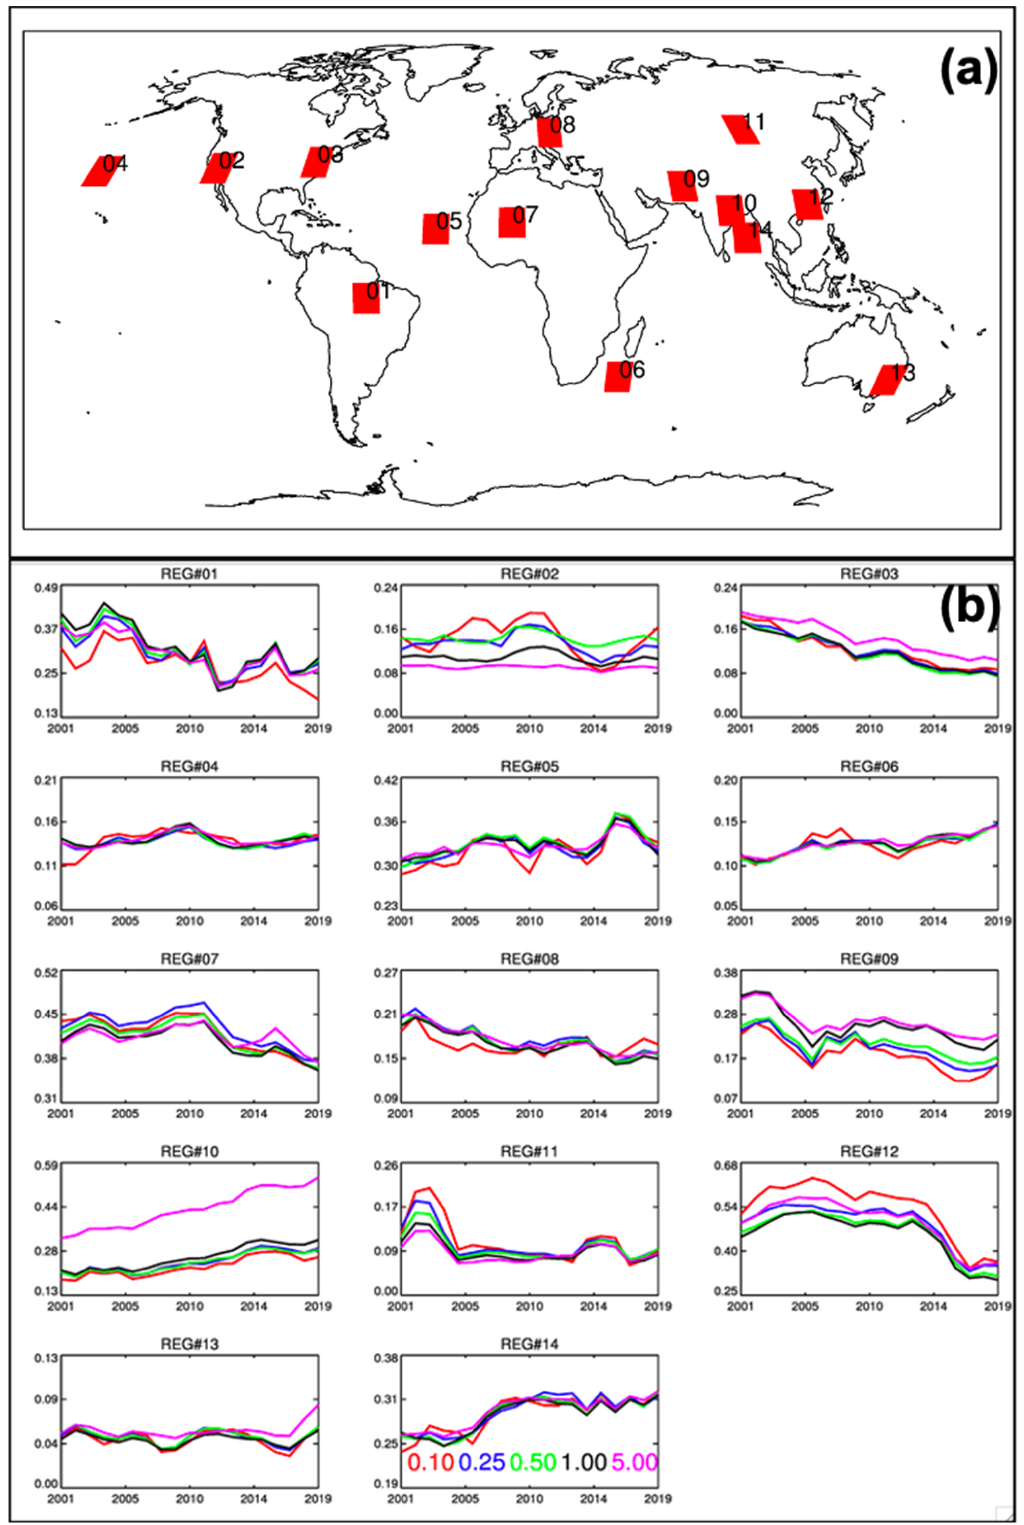
Figure 11. Timeseries of annual mean aerosol optical depth from MODIS-Terra for 14 selected regions around the globe. The top panel ( a ) shows the location of regions of the 5 × 5 degree box. The bottom panels ( b ) show the timeseries for each region, as shown on the map. The different colors on the timeseries plot represent different spatial averaging of 0.1, 0.25, 0.5, 1.0, and 5.0 degrees. The regions were selected to cover various surface types and representing different aerosol regimes.